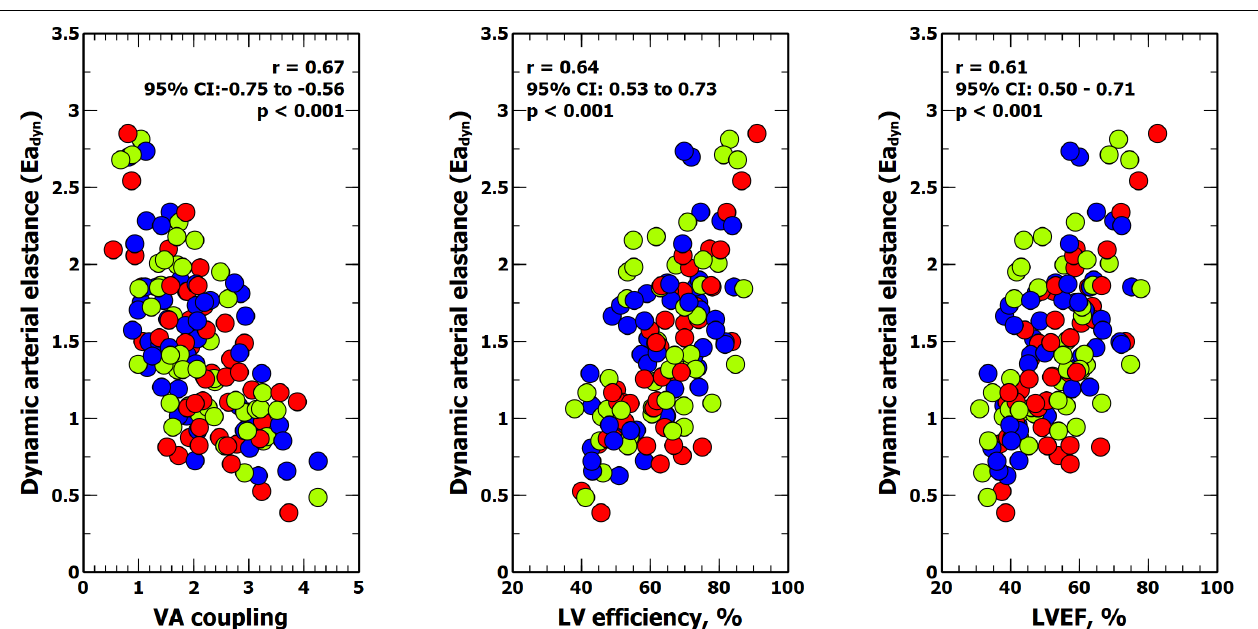
FIGURE 5 | Relationship between dynamic arterial elastance, ventricular-arterial (VA) coupling, left ventricular (LV) mechanical efficiency and left ventricular ejection fraction (LVEF). Colors inside circles represent different experimental interventions: red, afterload; green: preload; blue: contractility.